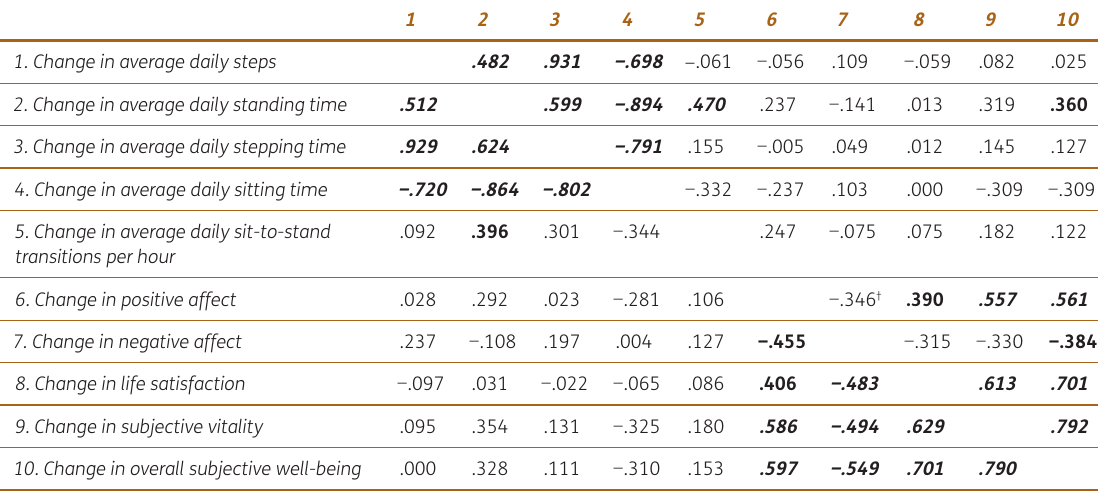
Table 6 Pearson correlation matrix between residuals and absolute differences of device-measured SB outcomes and outcomes of SWB. ( n = 31).